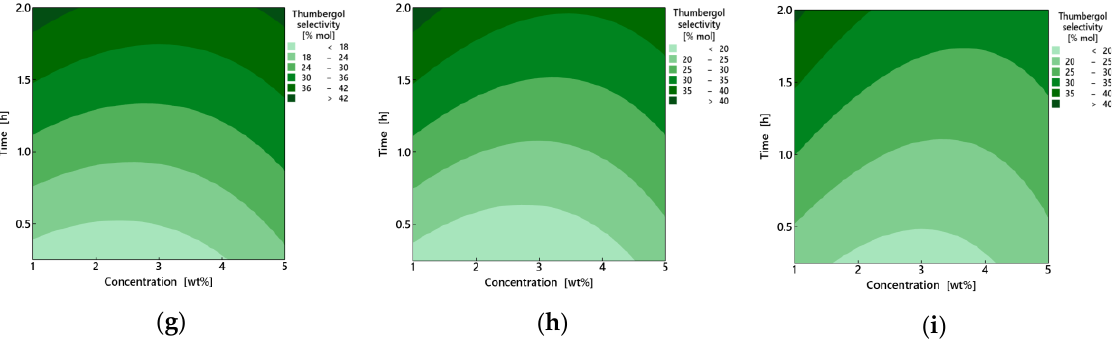
Figure 6. Contour plot of thumbergol selectivity at: time: ( a ) 0.25 h, ( b ) 1.125 h, and ( c ) 2 h, concentration: ( d ) 1 wt.%, ( e ) 3 wt.%, and ( f ) 5 wt.%, and temperature: ( g ) 20 °C, ( h ) 65 °C, and ( i ) 110 °C.